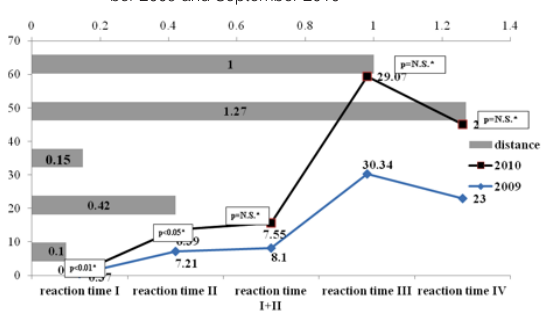
Figure 1. Comparison of response times (I-IV) between Septem- ber 2009 and September